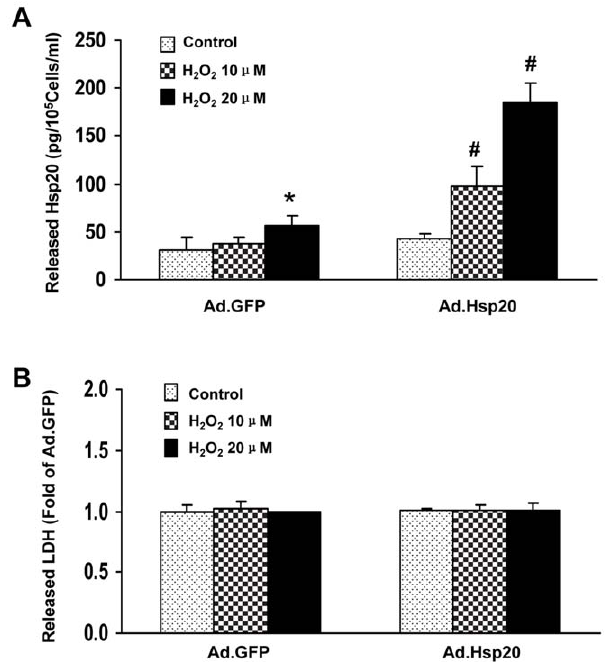
Figure 2. Overexpression of Hsp20 in adult cardiomyocytes enhances its secretion. (A) Mild stress dose-dependently increased the amount of Hsp20 released from both Ad.GFP and Ad.Hsp20 infected myocytes, and (B) there was no difference in the release of lactate dehydrogenase (LDH), a marker of necrosis. Similar results were observed in two additional, independent experiments (*, p , 0.05 vs. Ad.GFP-Control; # , p , 0.05 vs. Ad.GFP).